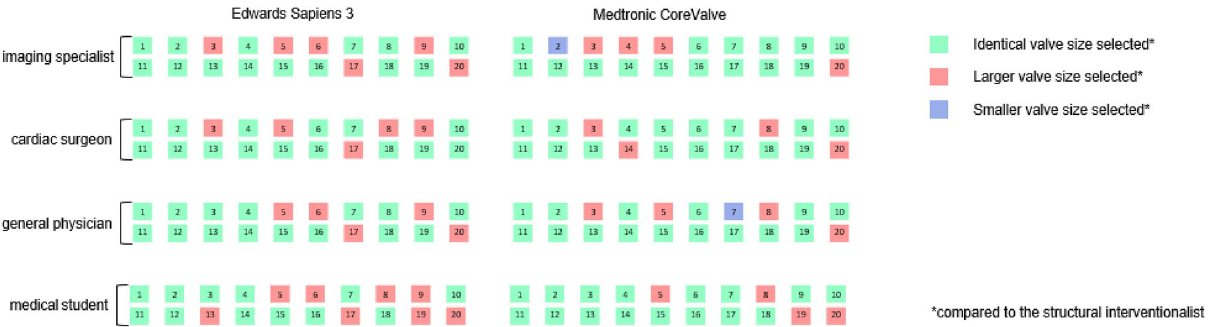
Figure 2. Valve size selection compared to the interventionalist for each patient, separated by valve